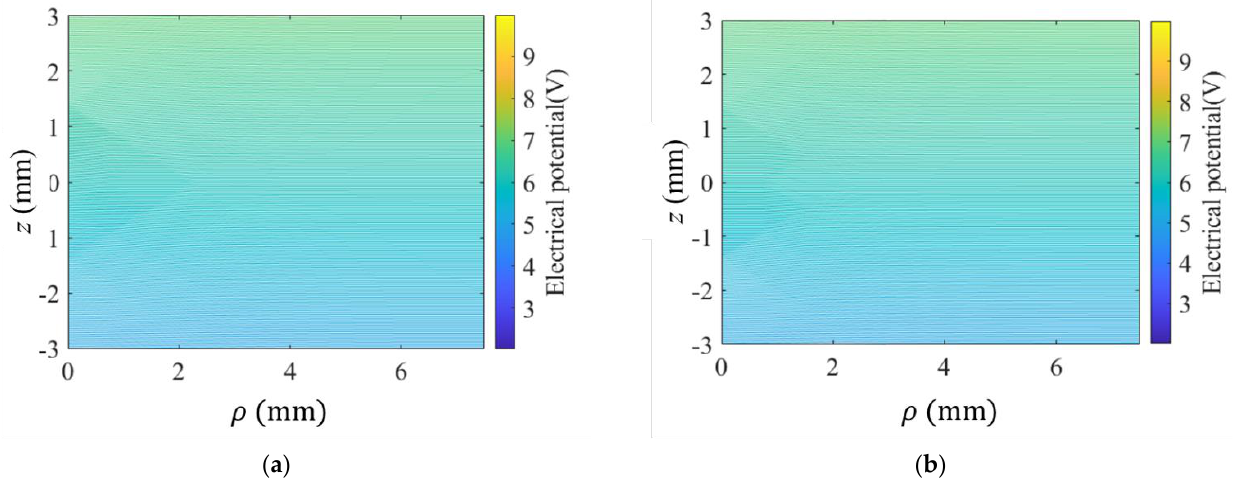
Figure 8. Electric potential distribution of a bubble in liquid nitrogen. ( a ) CFEM, ( b ) XFEM